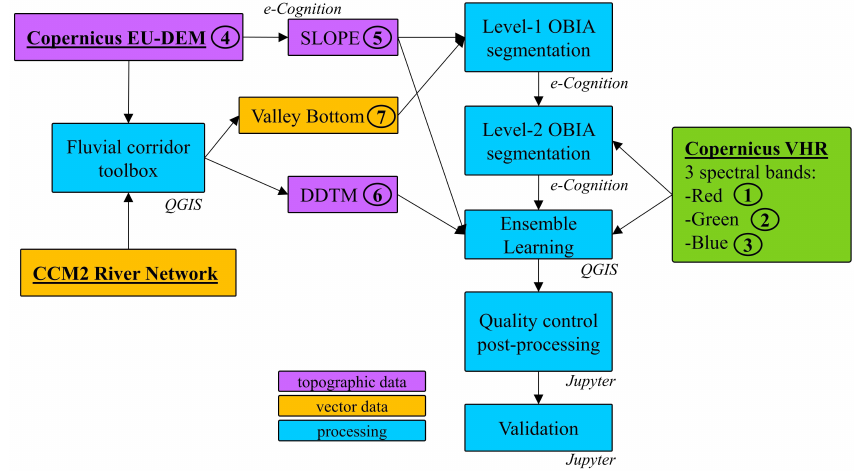
Figure 4. Di ff erent sources of data used and flowchart of the processing. Table 1. Number of processed tiles and corresponding areas per zone of